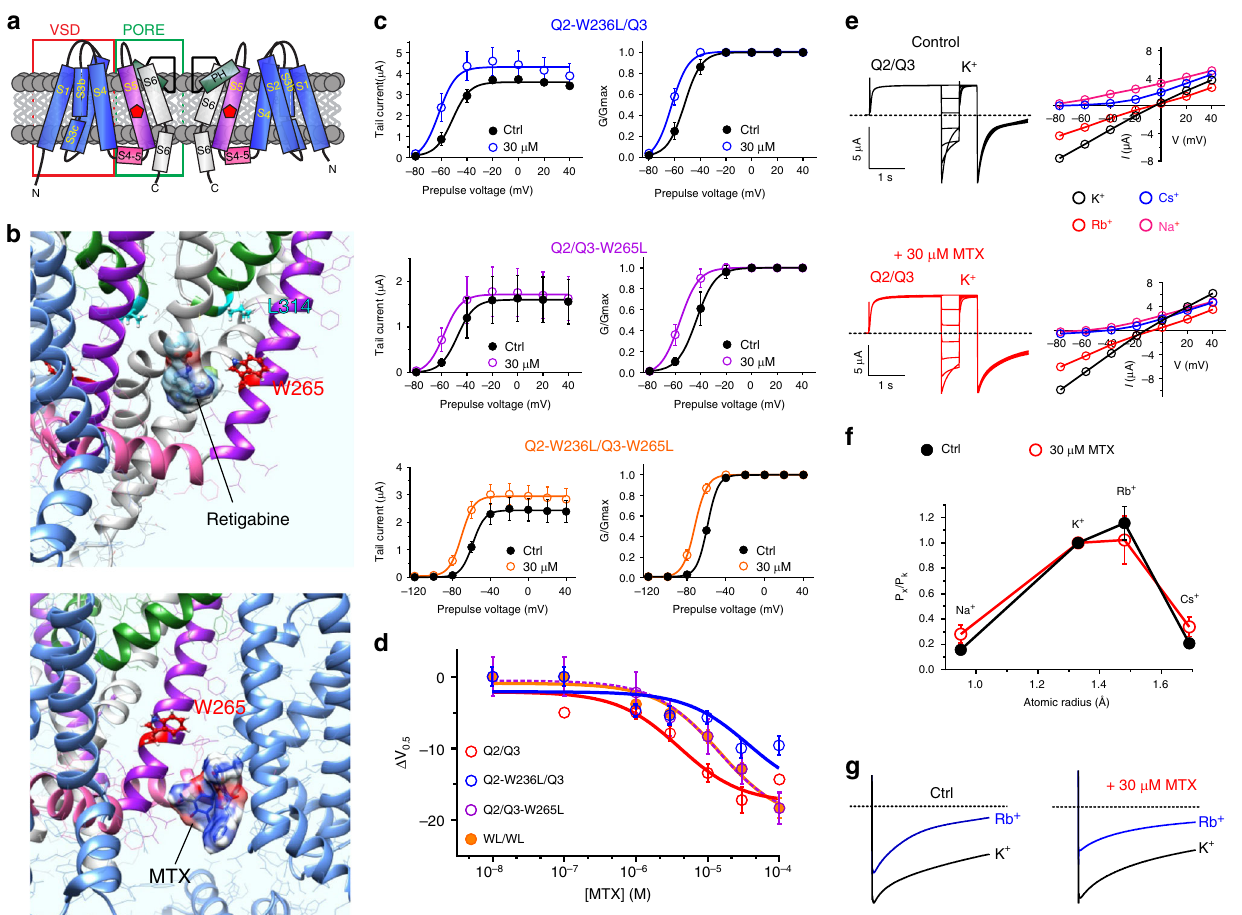
Fig. 3 MTX activates KCNQ2/3 by binding close to the pore. a KCNQ topology (two of four subunits shown) indicating approximate position of KCNQ3- W265. VSD voltage-sensing domain. b Binding position of ( upper ) retigabine and ( lower ) MTX in KCNQ3 predicted by SwissDock using a chimeric KCNQ1 – KCNQ3 structure model. c Effects of MTX (30 µ M) on tail current and G / G max relationships for single- and double-W/L mutant KCNQ2/3 channels as indicated ( n = 3 – 5). Voltage protocol as in Fig. 1d. d Dose response for mean Δ V 0.5 of activation induced by MTX for wild-type KCNQ2/3 and mutant channels as in c ( n = 3 – 9). e Left , exemplar traces; right , mean I / V relationships for KCNQ2/3 channels bathed in 100 mM K + , Rb + , Cs + , or Na + in the presence or absence (Control) of MTX (30 µ M); n = 4 – 7. f Relative ion permeabilities of KCNQ2/3 channels in the presence or absence (Ctrl) of MTX (30 µ M); n = 4 – 7. Quanti fi ed from traces and plots as in panel e . g Relative Rb + to K + permeabilities of KCNQ2/3 channels in the presence or absence (Ctrl) of MTX (30 µ M); n = 4 – 8. All error bars indicate